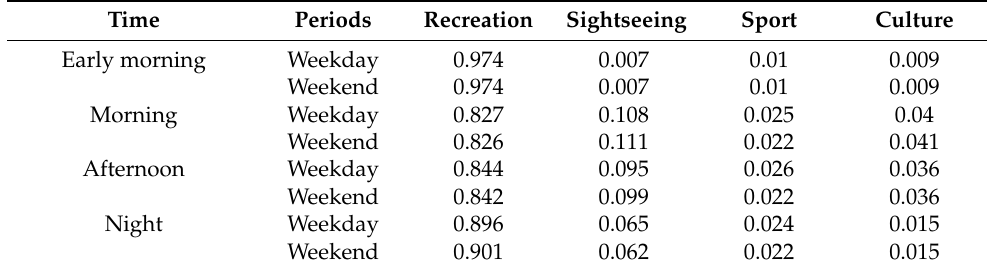
Table 5. The proportion of four types of leisure activity participants during different periods.